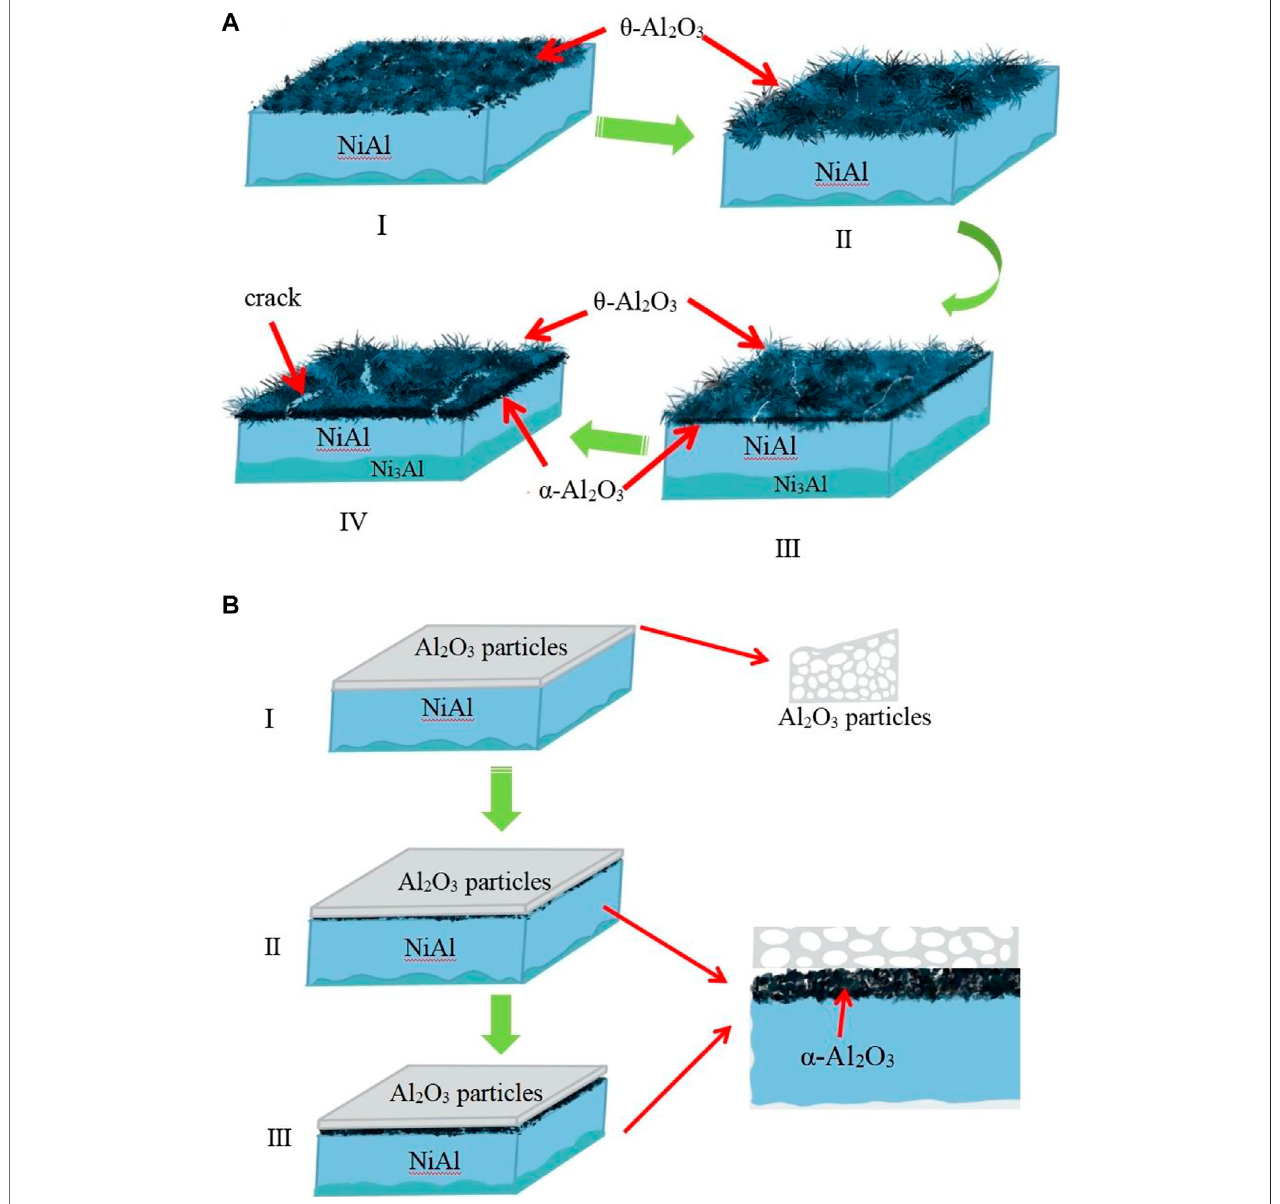
FIGURE 6 | Schematic transient oxidation progress of the Ni 2 Al 3 coatings (A) without and (B) with the surface Al 2 O 3 particles.